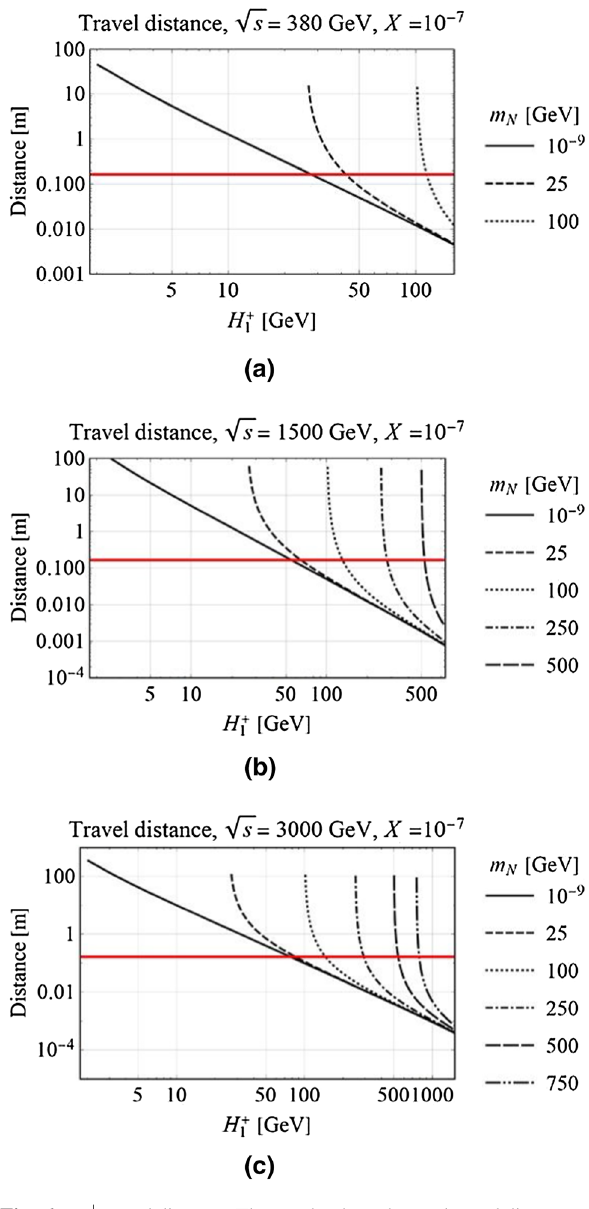
Fig. 5 H + travel distance. The graphs show the total travel distance of 1 H + for different values of m N and energy stages of CLIC ( a √ √ 1 s : 1500 GeV, c s : 3000 GeV), considering X = 10 − 6 . The GeV, b red line indicates the innermost tracker layer distance at 165mm from the center